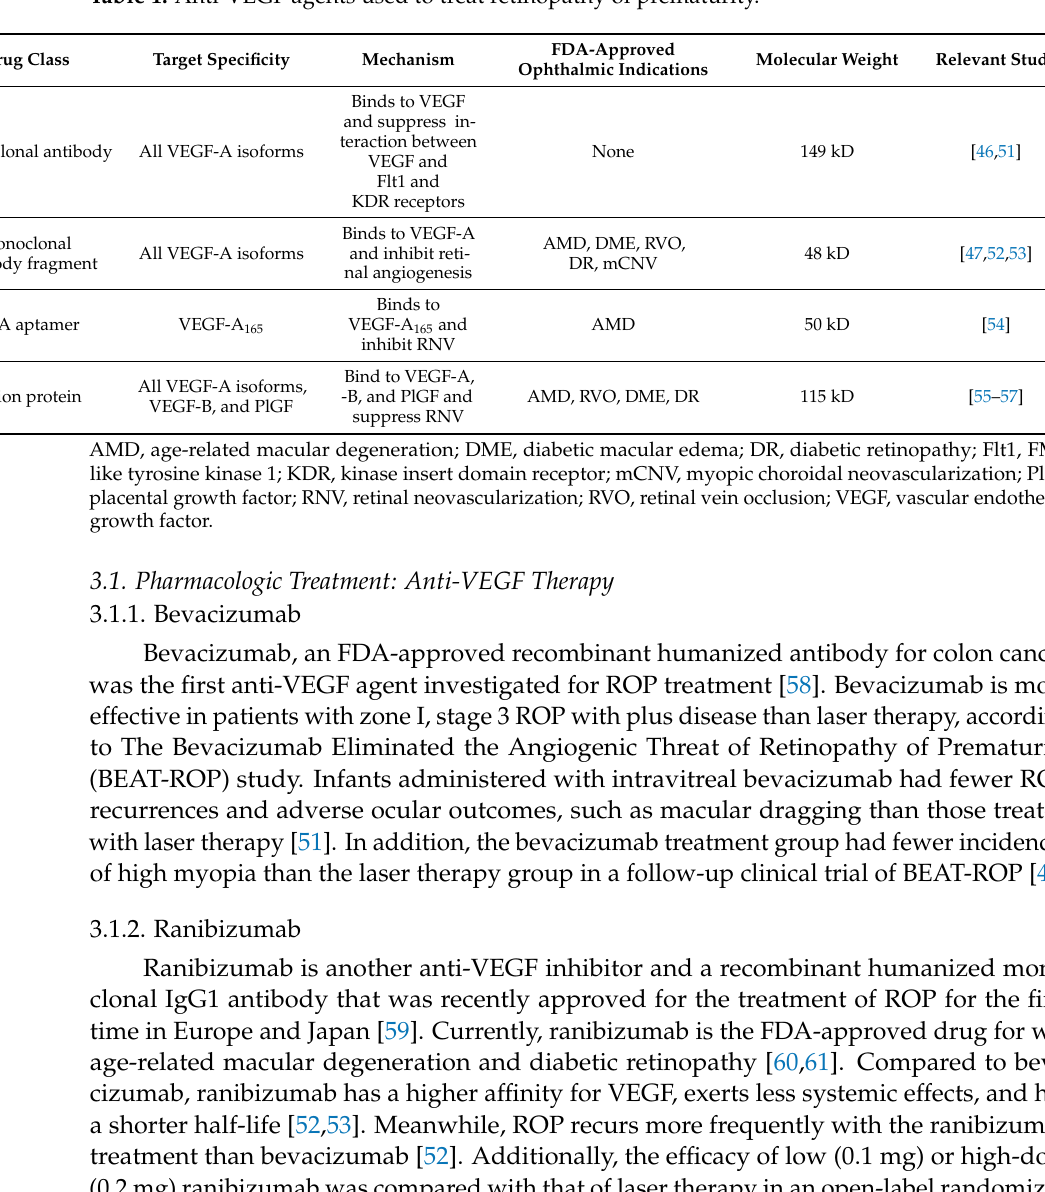
Table 1. Anti-VEGF agents used to treat retinopathy of